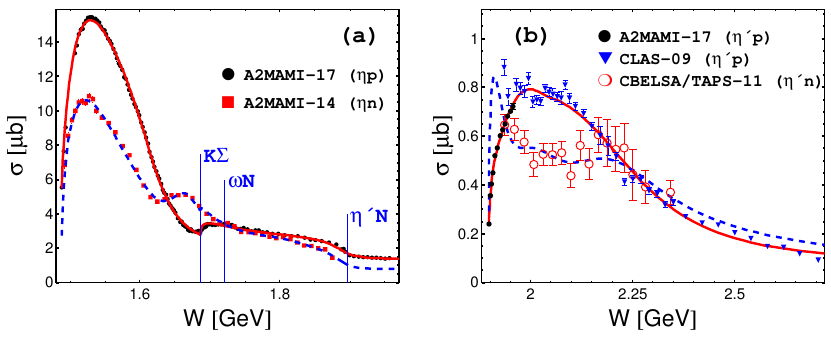
Figure 1. Total cross section for ( γ,η ) (a) and ( γ,η (cid:48) ) (b) on protons and neutrons. The solid red and dashed blue lines show our EtaMAID solution for proton and neutron, respectively. The data are from references [9] for η p , [10] for η n , [9, 11] for η (cid:48) p and [12] for η (cid:48) n